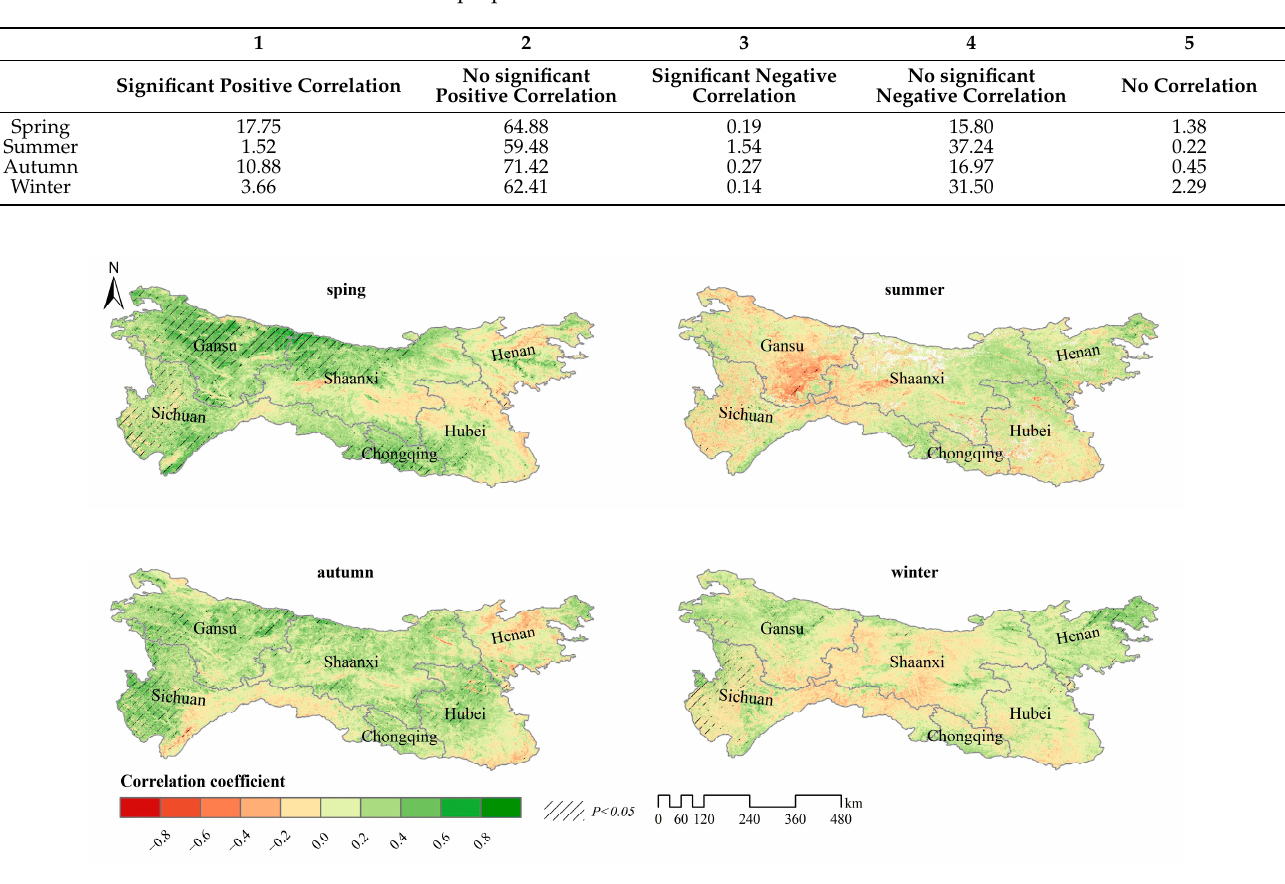
Figure 13. Spatial distribution of the correlation between seasonal FVC and TEM in the QBM from 2000–2020. Table 11. Area proportion of correlation level between FVC and